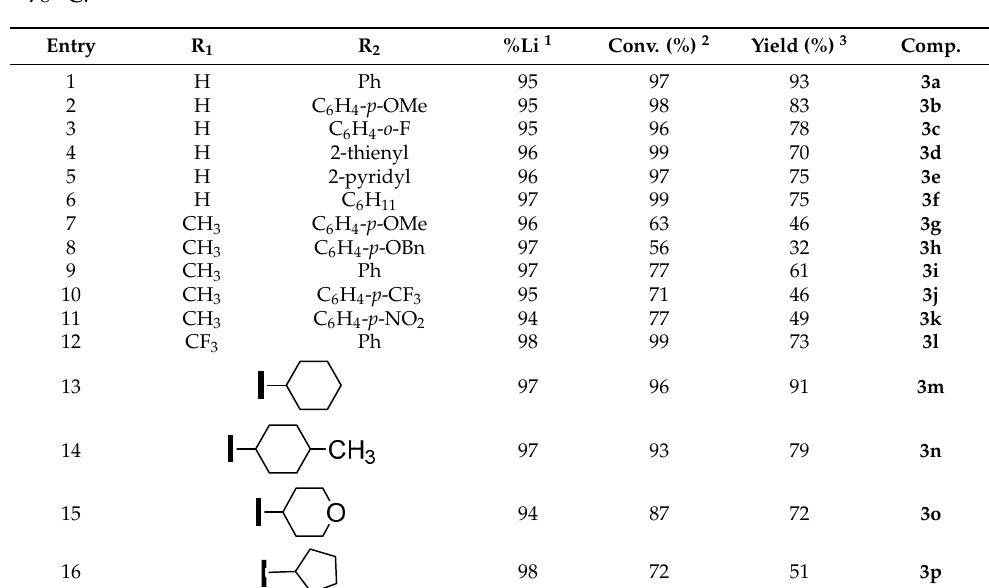
Table 2. Evaluation of the substrate scope in lithiation addition reaction using 16 different aldehydes and ketones. The reactions were run using ca 500 mg of 1 with BDMAE as an additive in THF at − 78 °C.